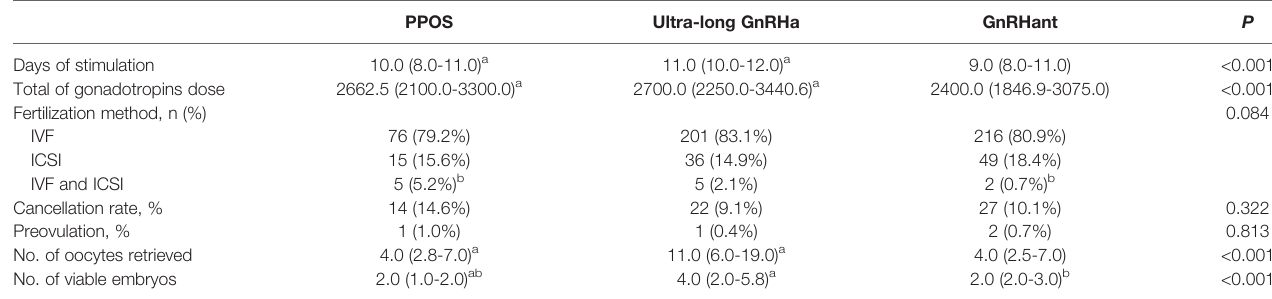
TABLE 2 | Stimulation cycle characteristics of the patients in the three groups.